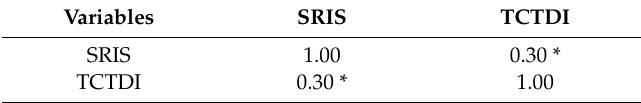
Table 3. Correlation between reflection and critical thinking ( n =